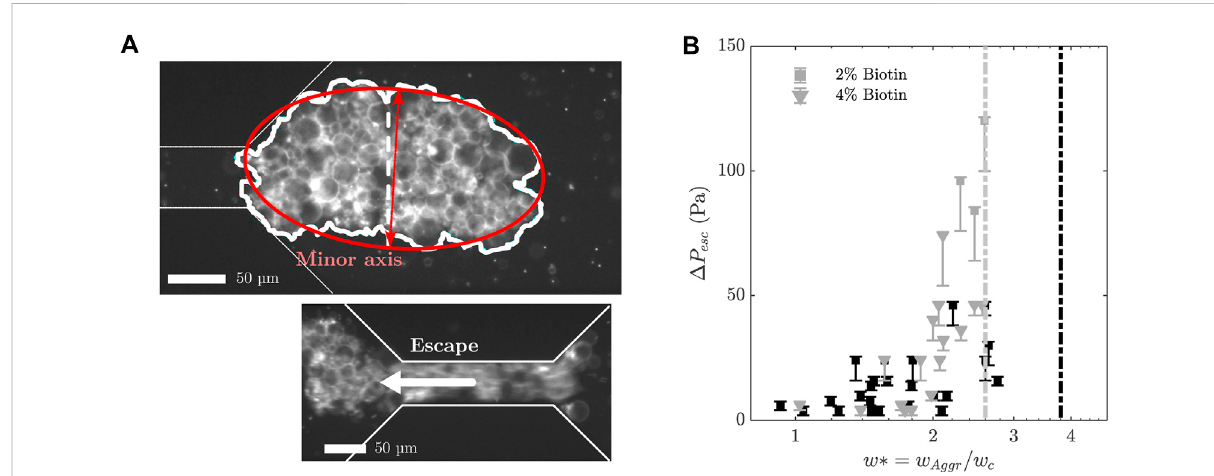
FIGURE 2 Clogging behaviour of vesicle aggregates in the constriction. (A) Top: example of a vesicle aggregate entering the channel constriction. The aggregate size was set as the minor axis of the fi tted ellipse (red). Bottom: example of an aggregate at the moment at which it exits the constriction. (B) Escape pressure as a function of the normalized aggregate size ( w * = w Aggr / w c ). Squares and triangles correspond to 2% and 4%-biotin aggregates, respectively. Black and gray colors refer to experiments performed in constrictions of width 50µm and 100 µm respectively. The maximum value of w * is given by the ratio of the channel and the constriction widths. These values are indicated in the fi gure with dashed vertical lines. Error bars correspond to the standard deviation of the imposed pressure (upper bar) and to the step of the applied pressure (lower